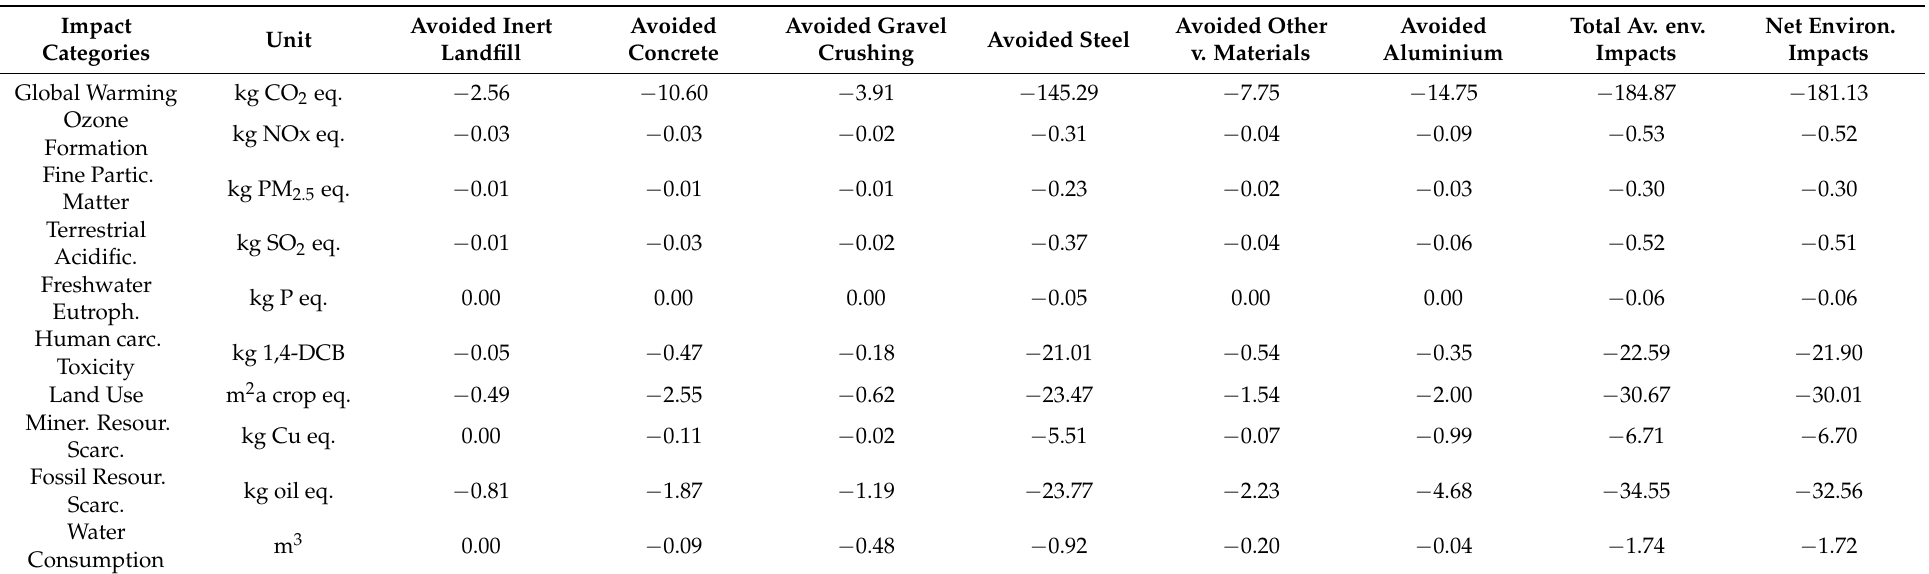
Table 6. Environmental avoided characterized impacts in the life cycle of 1 tonne of